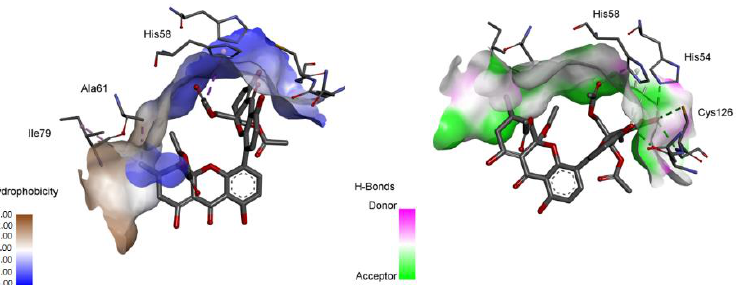
Figure 4. Diagram of hydrophobic surfaces and hydrogen bonds between phomoxanthone A and LuxS (PD ID 2FQO). The figure was generated by the Biovia Discovery Studio Visualizer software (v19.1.0.18287, BIOVIA, San Diego, CA, USA).